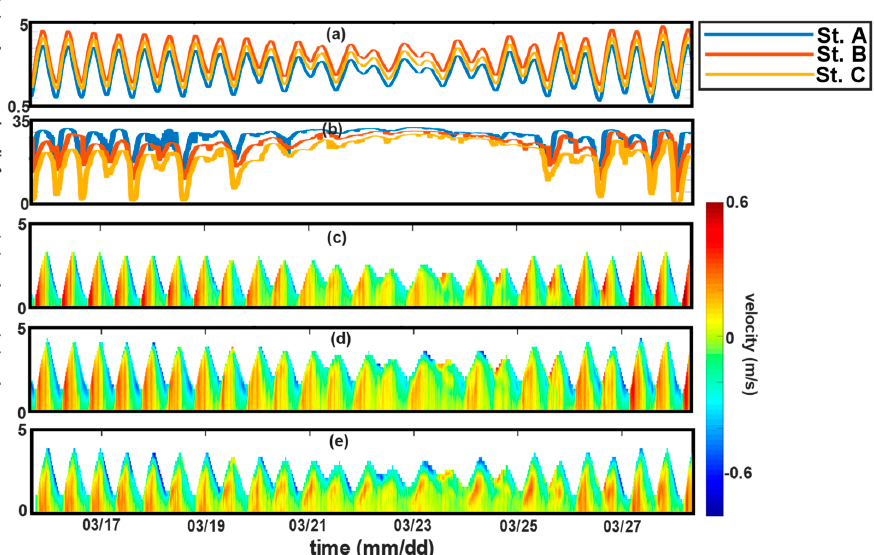
Figure 2. Time series plot of observed water depth ( a ), near-bottom salinity ( b ), and current velocities in station A ( c ), station B ( d ), and station C ( e ).